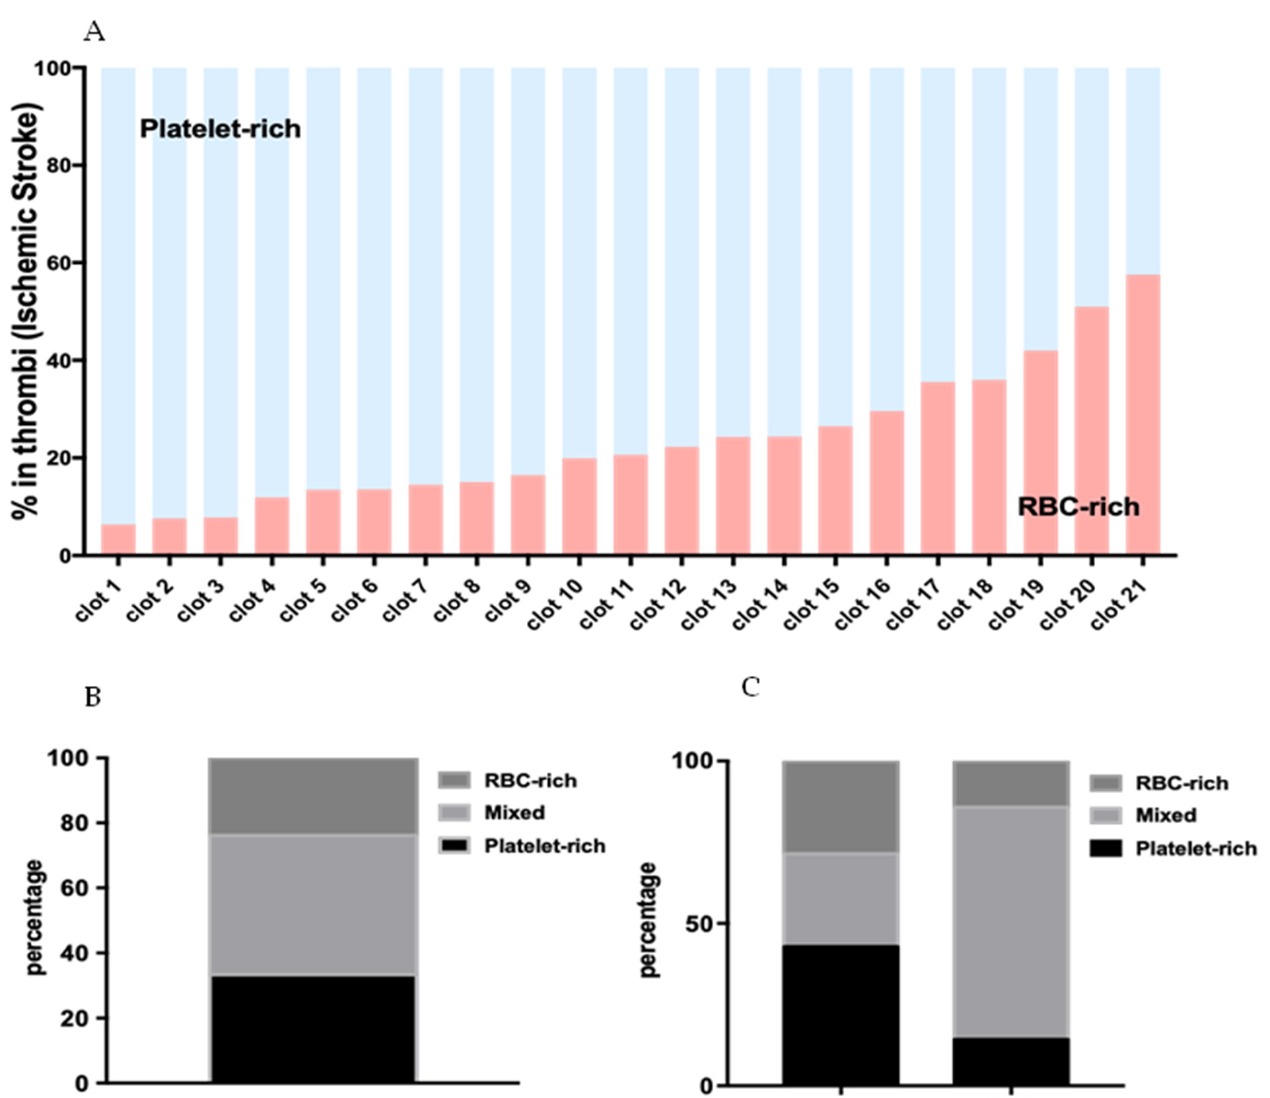
Figure 3. Composition of the stroke thrombi. ( A ) Quantitative analysis of the stroke thrombi using H&E staining was performed and the percentage of RBC-rich areas (red) and platelet-rich areas (light blue) was determined. All the thrombi contain significant amounts of platelet-rich and RBC-rich areas. Individual thrombi differ in composition with some showing an abundance of platelet-rich areas while others an abundance of RBC-rich areas (n = 21, vertical bars). ( B ) Bar diagram showing the classification of stroke thrombi based on the percentage of platelet-rich and RBC-rich areas. The majority consisted of mixed thrombi. ( C ) Percentage of RBC-rich, mixed, and platelet-rich thrombi in control vs. group that received t-PA.